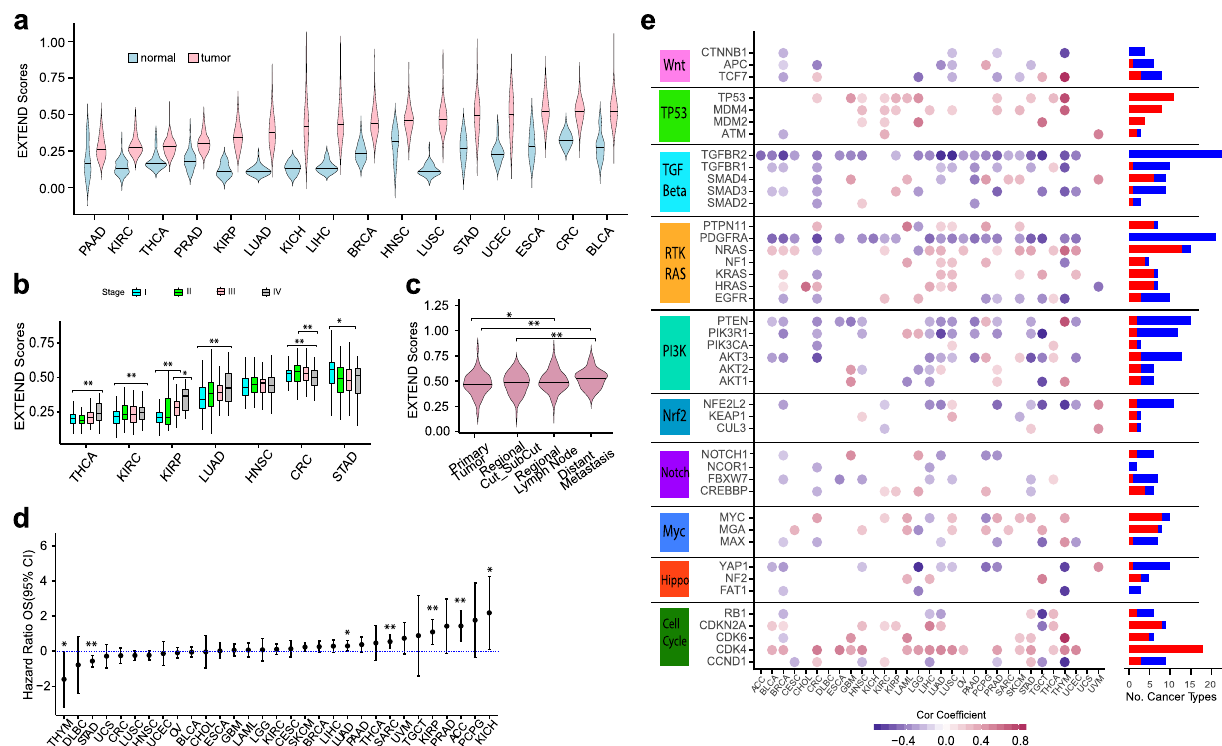
Fig. 3 EXTEND scores in cancer. a EXTEND scores for TERT -expressing tumors and normal samples across 16 TCGA cancer cohorts. Violin width indicates data point density. Middle bar, median. b EXTEND scores across tumor stages (CRC = 338, HNSC = 420, KIRC = 375, KIRP = 254, LUAD = 497, STAD = 374, and THCA = 499 cases in total). Only tumor types with a minimum of ten cases for each stage were used in this analysis. P values were calculated using two-sided t test. * P < 0.05; ** P < 0.01. Box indicates 25 – 75th quantile range. Middle bar indicates median. The minima and maxima are within 1.5 times the interquartile range of the lower and higher quartile. c EXTEND scores of cutaneous melanomas (TCGA SKCM). Violin width indicates data point density. Middle bar, median; two-sided t test. * P < 0.05; ** P < 0.01. d Hazard ratio plot based on univariate Cox regression model for 31 cancer types. Vertical bars indicate upper and lower limits of the 95% con fi dence interval of the hazard ratio estimates. P values are highlighted for signi fi cant cases only (* P < 0.05; ** P < 0.01). The y -axis is in the natural log scale. e Correlations between EXTEND scores and gene expression of ten oncogenic signaling pathways across 31 cancer types. Signi fi cant correlations (FDR < 0.05) are shown in either red (positive correlation) or blue circles (negative correlation). The frequency of each gene ’ s positive and negative correlation patterns across different cancer types is summarized on the right. Data used for the fi gure is available in Source